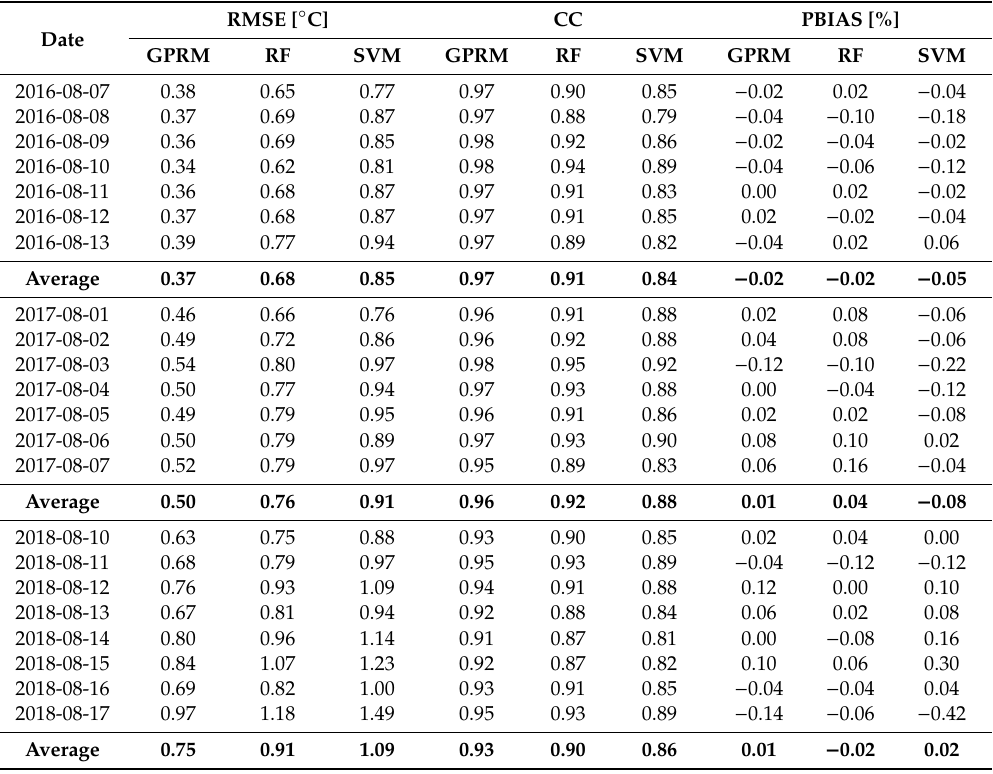
Table 4. Cross-validation results via spatial prediction techniques applied to daily minimum